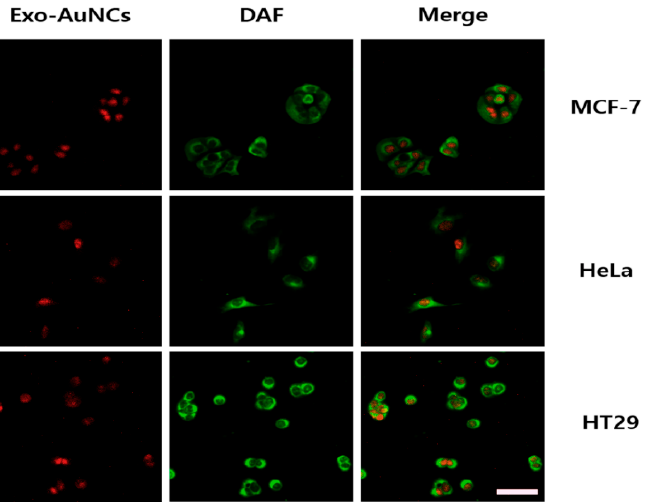
Figure 5. Fluorescence imaging using exo-AuNCs. Scale bar: 50 µm. The cell membrane was counterstained with 5-dodecanoylaminofluorescein (500 µM). The concentration of red-emitting exo-AuNCs was 3.125 mg/mL.